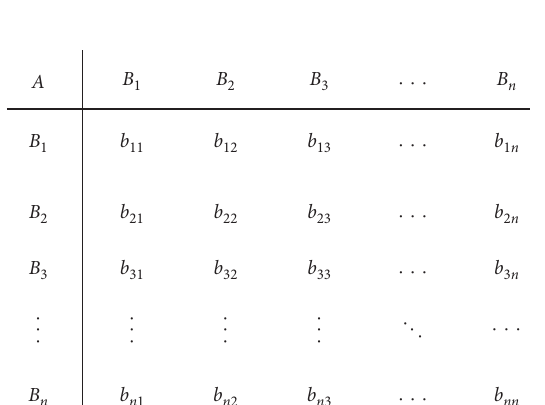
Figure 8: Factor set A.